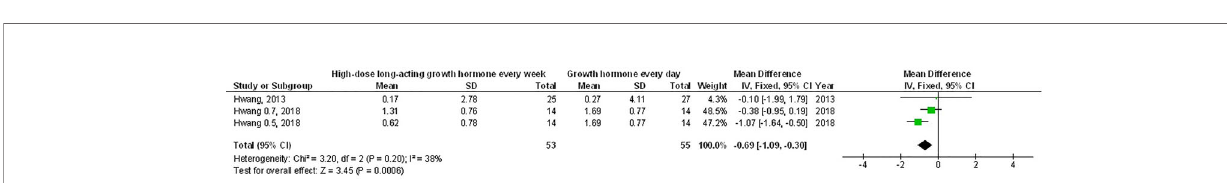
FIGURE 6 | Forest plot of the change in insulin-like growth factor binding protein-3 in long-acting growth hormone replacement therapy compared to daily growth